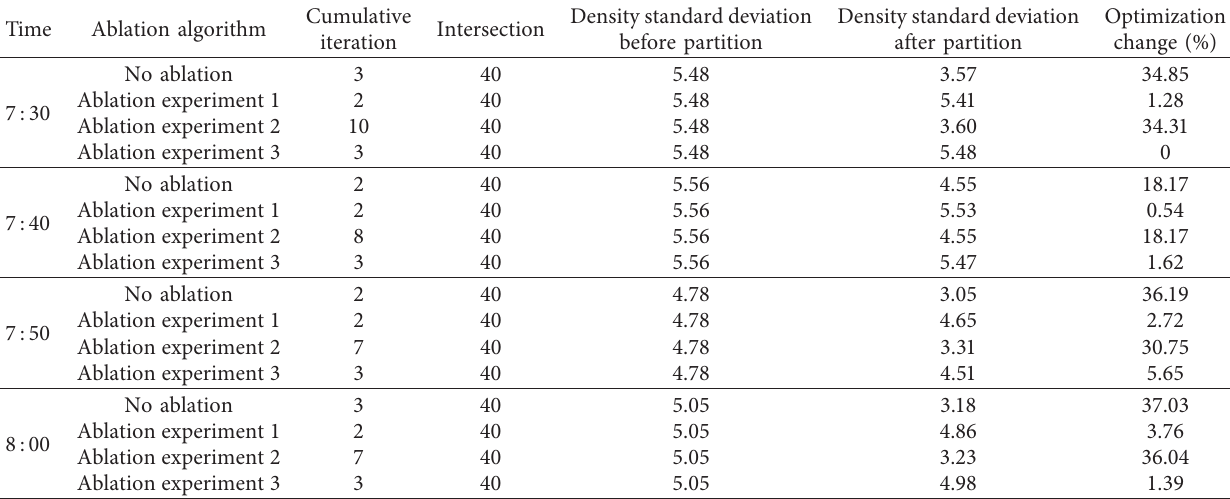
Table 9: Comparison of ablation experiment